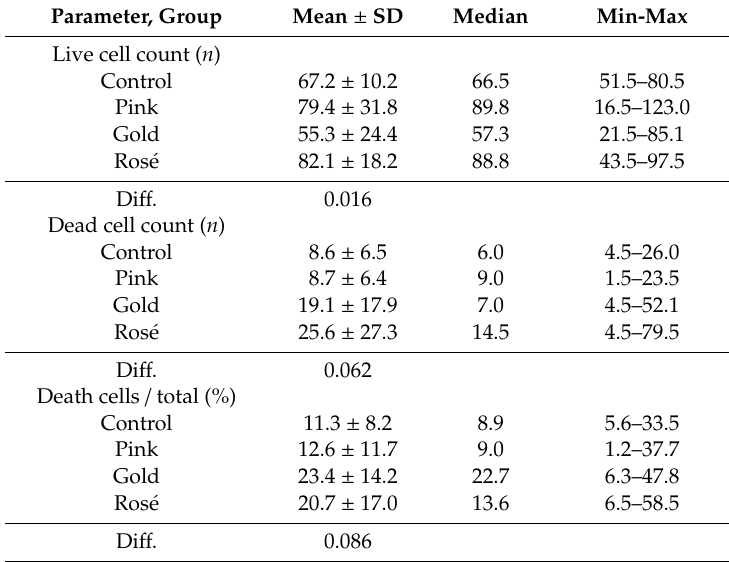
Table 2. Cell viability analysis (as number of live and dead cells, and percentage dead cells on total) results for the di ff erent groups. Parameter, Group Mean ± SD